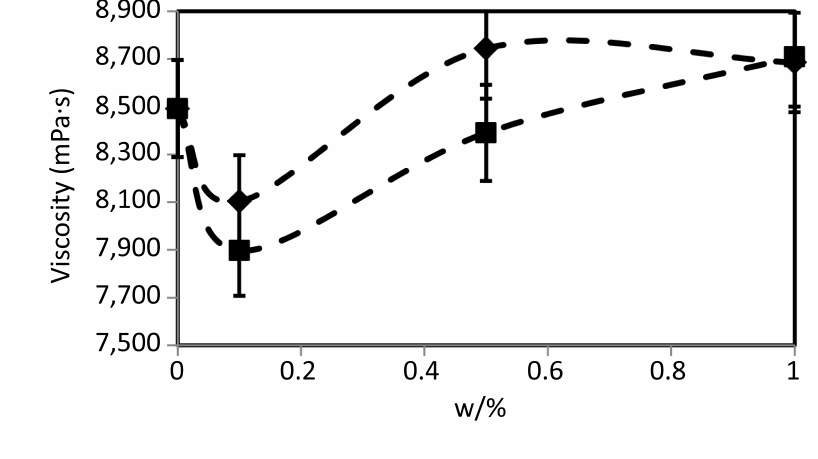
Figure 41. Comparison of the effect on the absolute viscosity of the iron particle size (at 25 °C) as a function of the catalyst concentration: (cid:7) micron-sized iron; (cid:4) nano-sized iron. Figure reproduced from Ref.